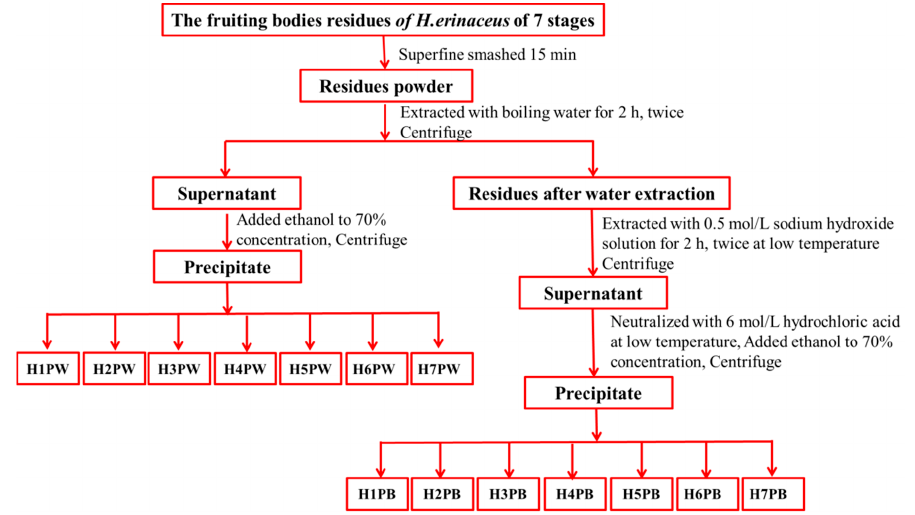
Figure 2. Stepwise extraction procedure of cell wall polysaccharides from H. erinaceus fruit bodies at 7 growth stages. 7 growth